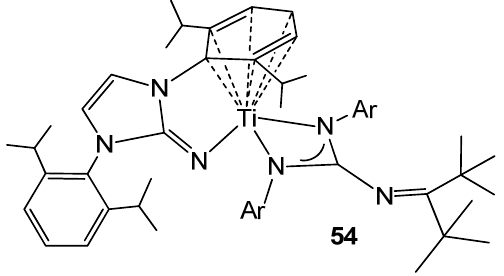
Figure 31. Coordination and activation of dinitrogen with group 4 guanidinato complexes.